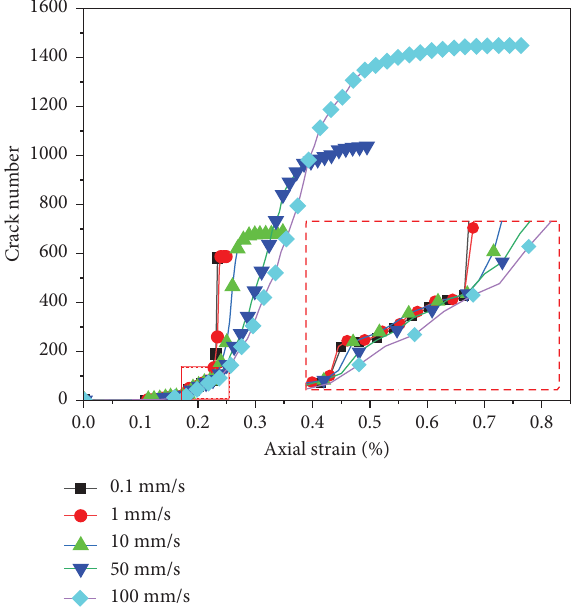
Figure 9: Graph of the evolution of cracks in the backfll.